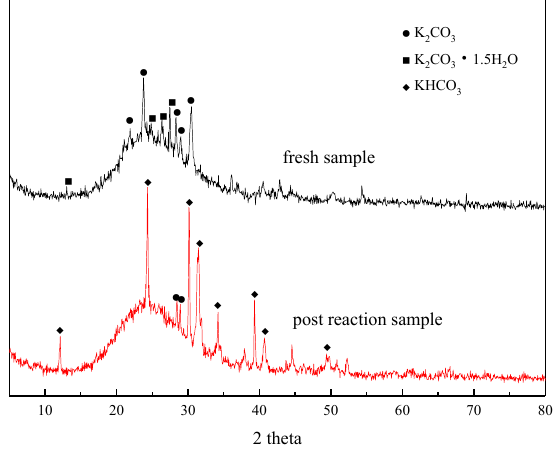
Figure 4. XRD patterns before reaction and after reaction.